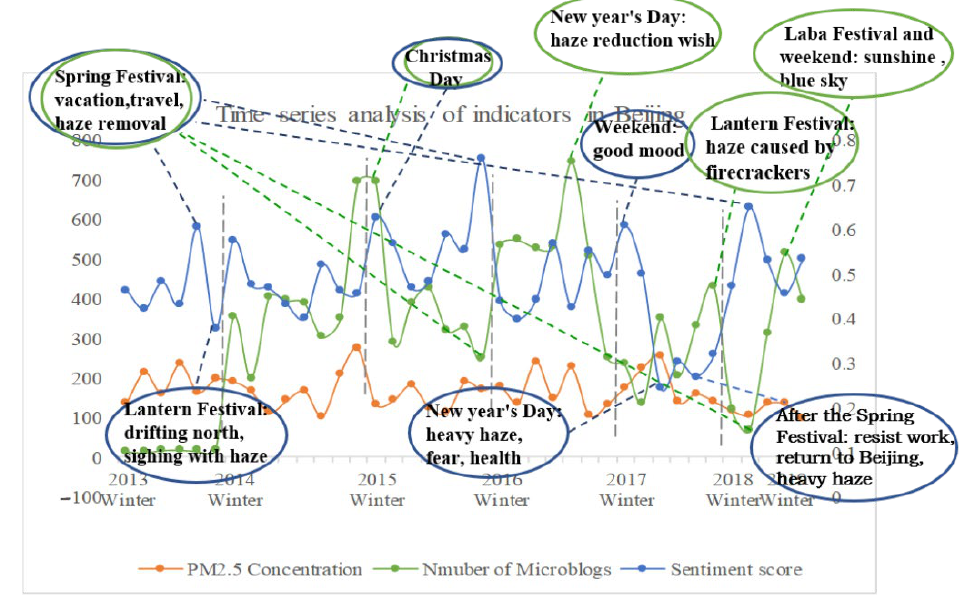
Figure 6. Indicator timeseries study in Beijing.